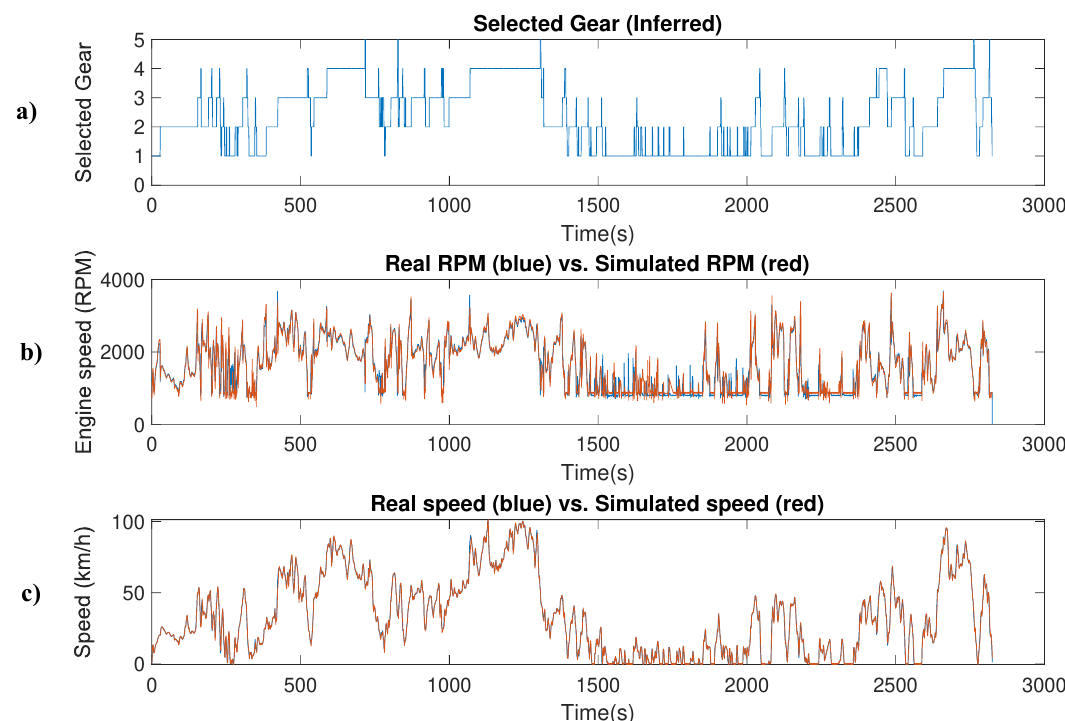
Figure 5. Comparison of measured data vs. simulation results. ( a ) The inferred gear considering the computed rpm/speed ratios. ( b ) The measured revolutions per minute (RPM) of the vehicle vs. the RPM simulated by the model. ( c ) The measured speed of the vehicle vs. the speed simulated by the